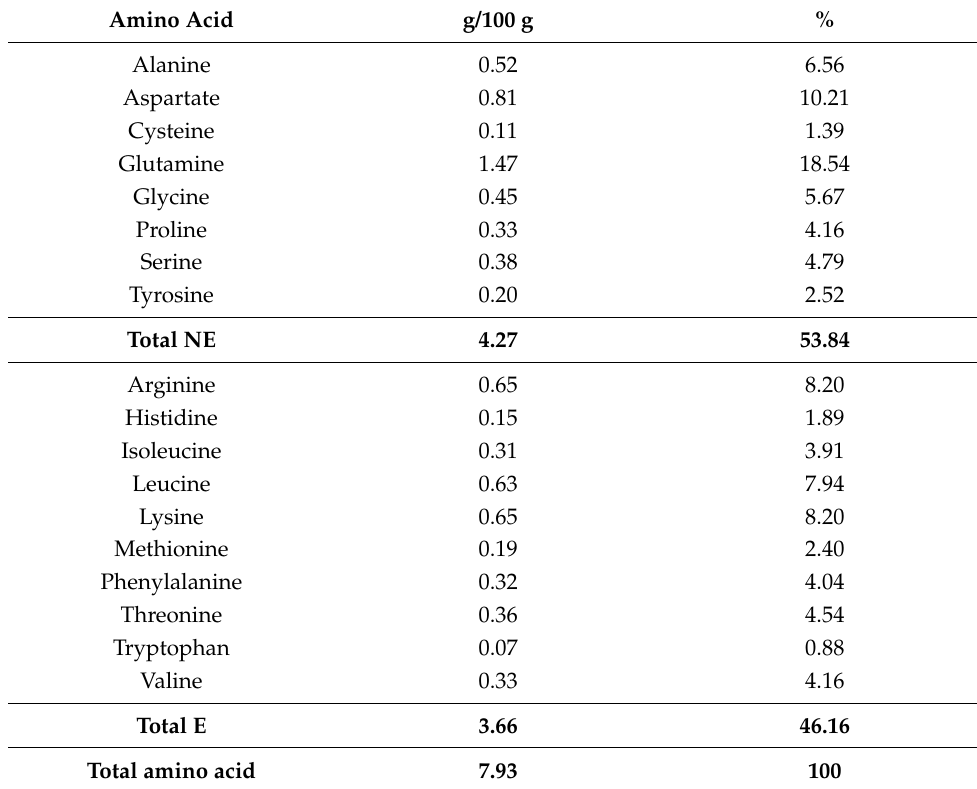
Table 8. Amino acid analysis of test seafood HMR products consisting of a mixture of AMPS, CSM, and sauce. Amino Acid g/100